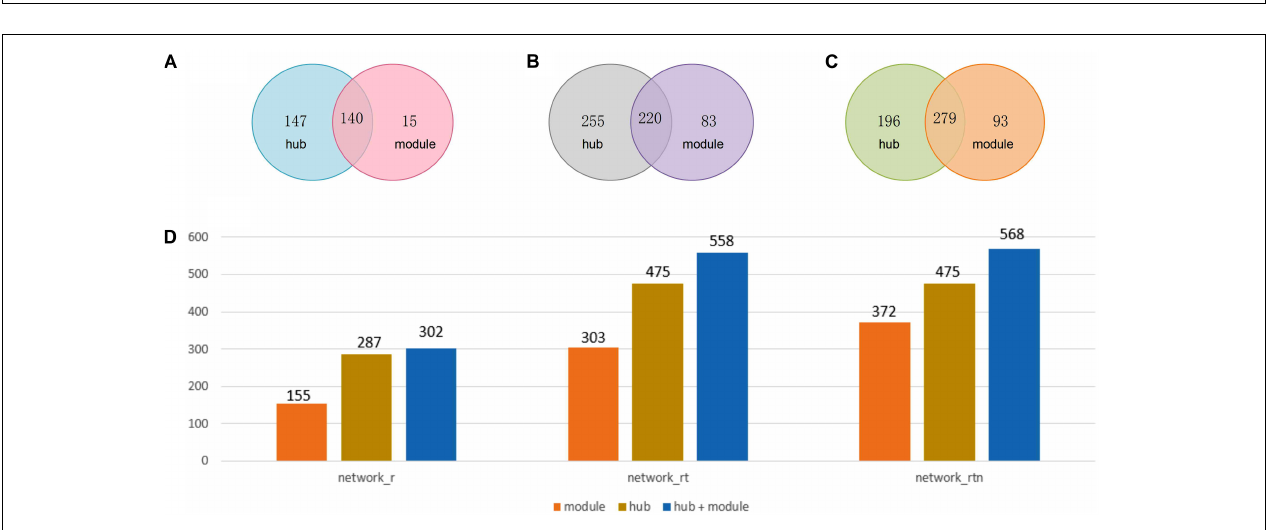
FIGURE 3 | Statistics of SEPs hub and module methods in three networks. (A) The count of hub nodes and module nodes in RNA co-expression network (network_r). (B) The count of hub nodes and module nodes in RNA and translation products co-expression network (network_rt). (C) The count of hub nodes and module nodes in co-expression and neighbor relation network (network_rtn). (D) Box plot of nodes distribution of hub and module methods in three networks.